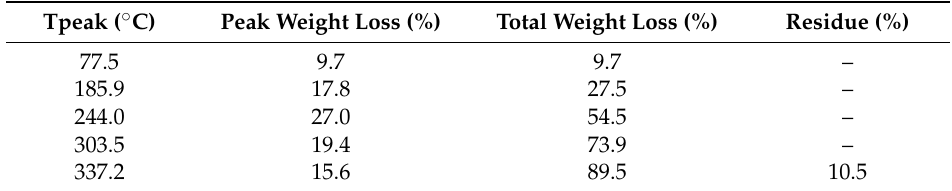
Table 3. Thermal parameter for whey/sorbitol.